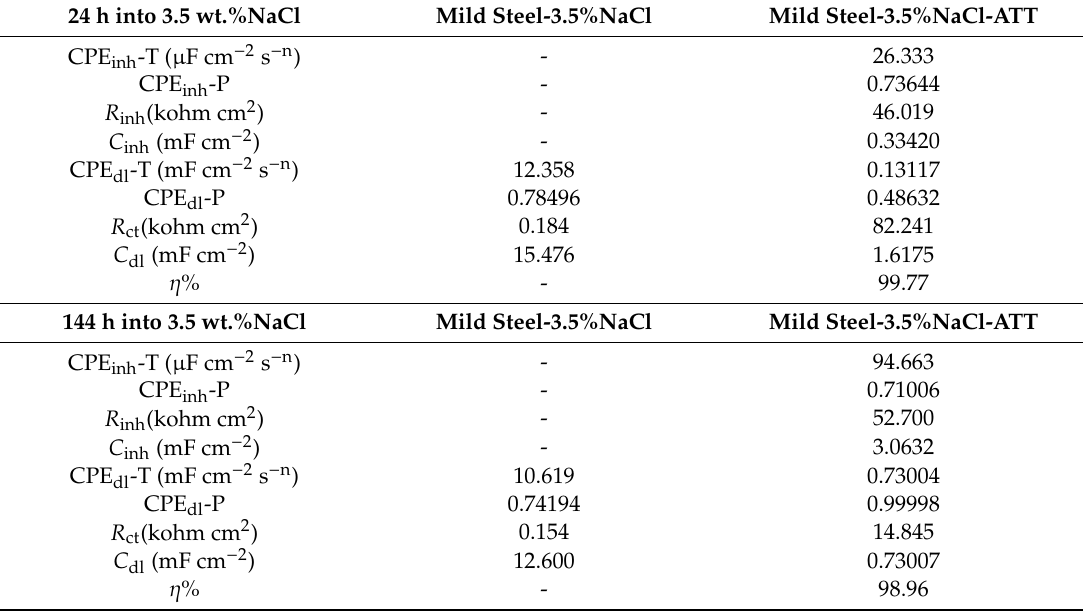
Table 5. Fitting parameters according to equivalent circuits of Figure 10 obtained for the mild steel subjected in corrosive